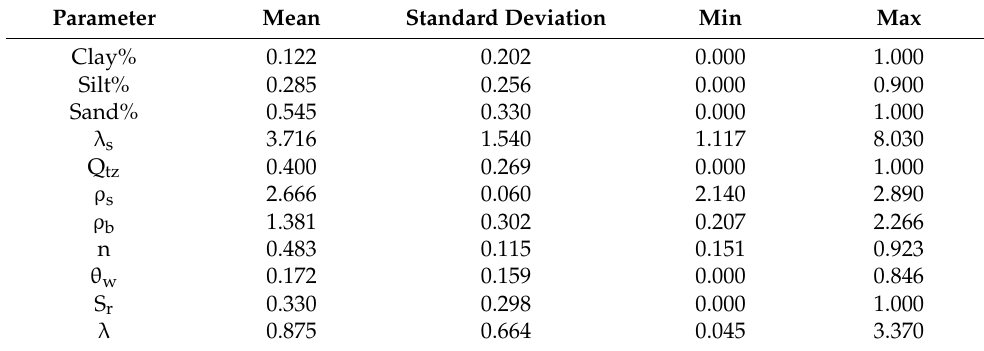
Table 2. Eigenvalues of the STC dataset.